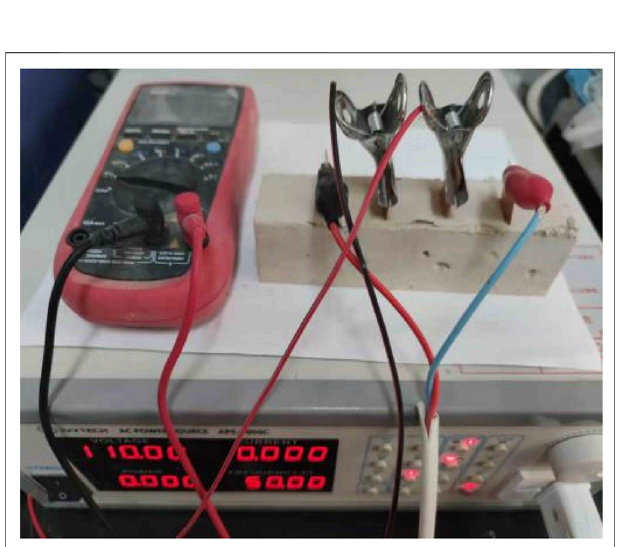
Frontiers in Materials |